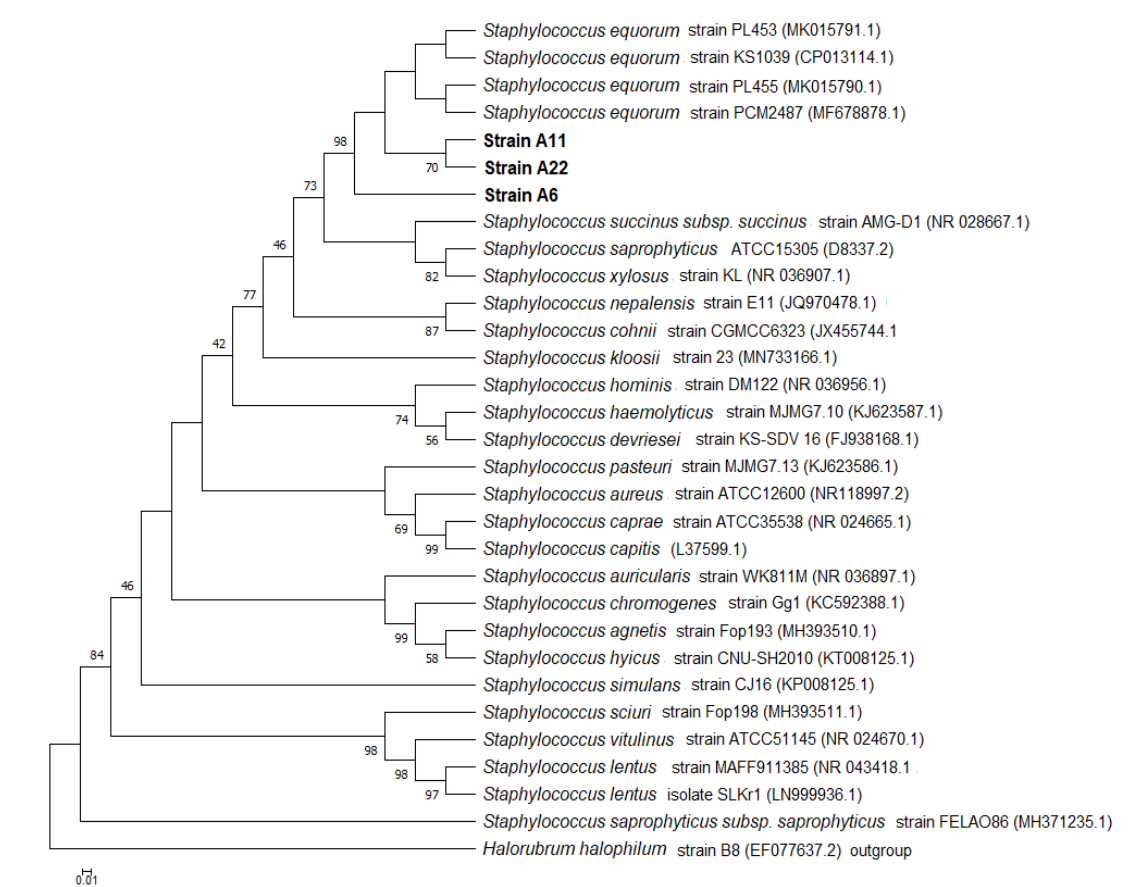
Figure 1. Molecular phylogenetic analysis by Maximum Likelihood method and General Time Reversible model [30]. The bootstrap consensus tree inferred from 1000 replicates is taken to represent the evolutionary history of the taxa analyzed [27]. The percentages of replicate trees in which the associated taxa clustered together in the bootstrap test (1000 replicates) are shown next to the branches [27]. Initial tree(s) for the heuristic search were obtained by applying the Neighbor-Joining method to a matrix of pairwise distances, estimated using the Maximum Composite Likelihood (MCL) approach. This analysis involved 31 nucleotide sequences. There were a total of 1670 positions in the final dataset. All positions containing gaps and missing data were eliminated. Thus, the strains A6, A11 and A22 are included in the analysis. The scale bar indicates the branch lengths measured in the number of substitutions per site.